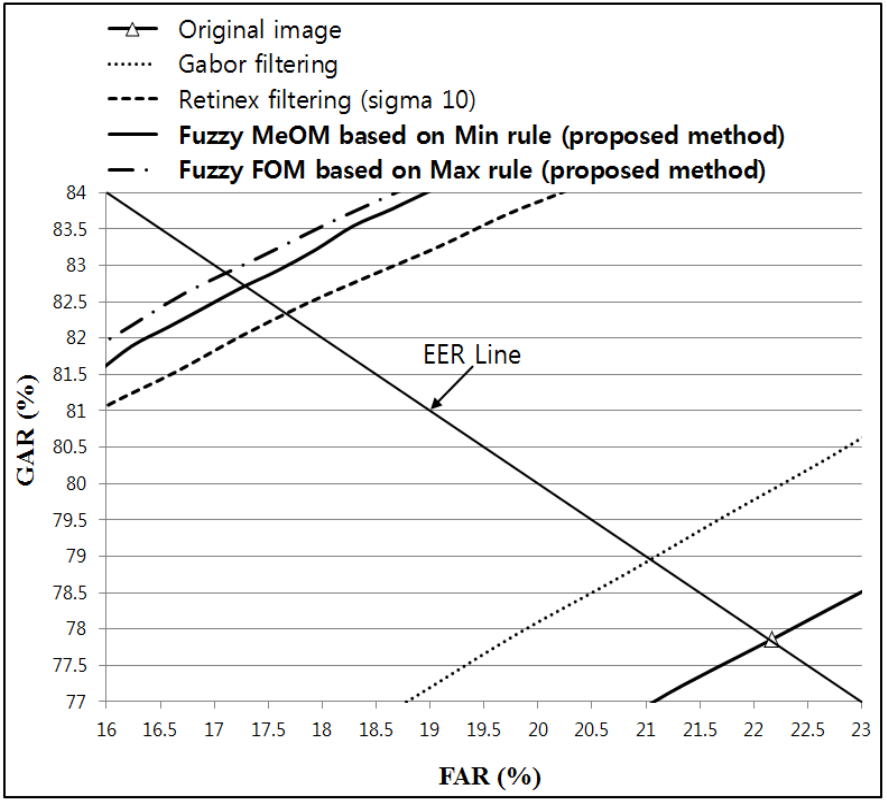
Figure 22. ROC curves obtained using the proposed method with Gabor filtering and Retinex filtering, with a sigma value of 10, and a Daubechies wavelet for images from database I.